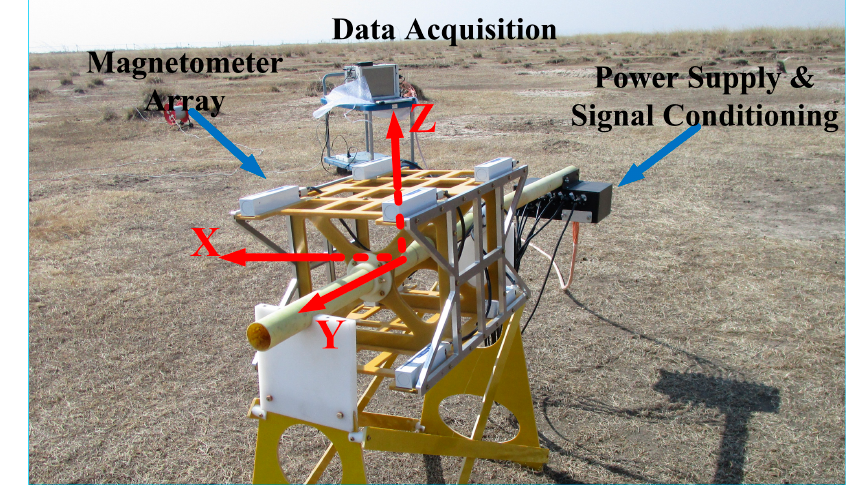
Table 1 . The Specification of the Magnetometer and Data Acquisition.